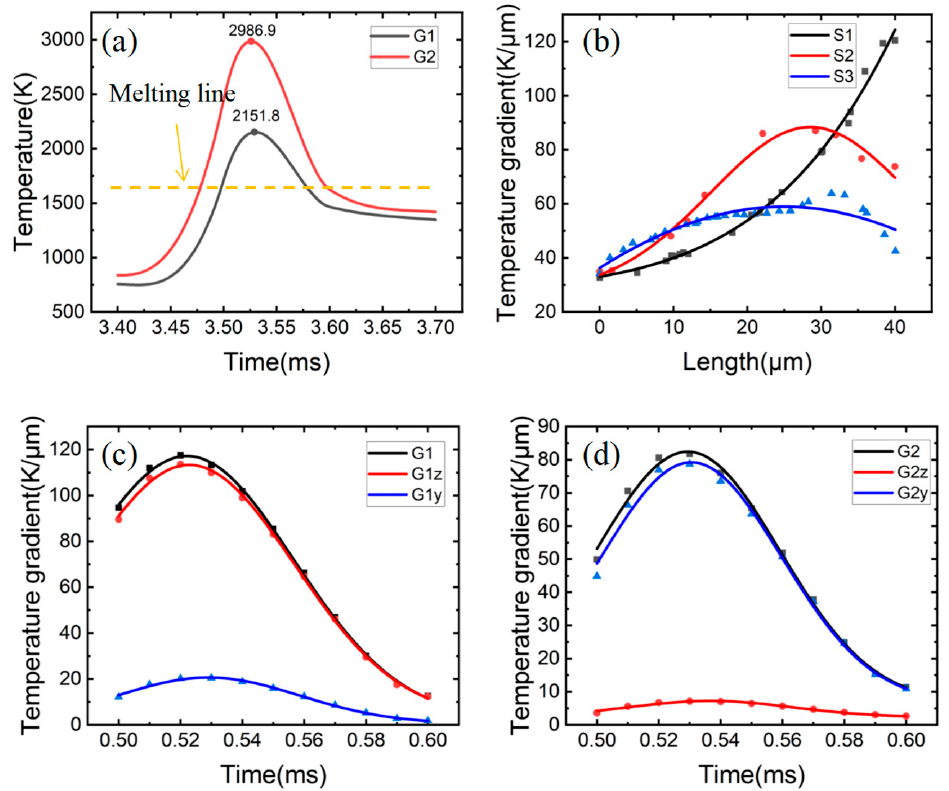
Figure 8. Model verification. ( a ) Temperature change at different positions of molten pool; ( b ) Map of temperature gradient with location; ( c ) Temperature gradient at the bottom of molten pool; ( d ) Temperature gradient on both sides of molten pool.